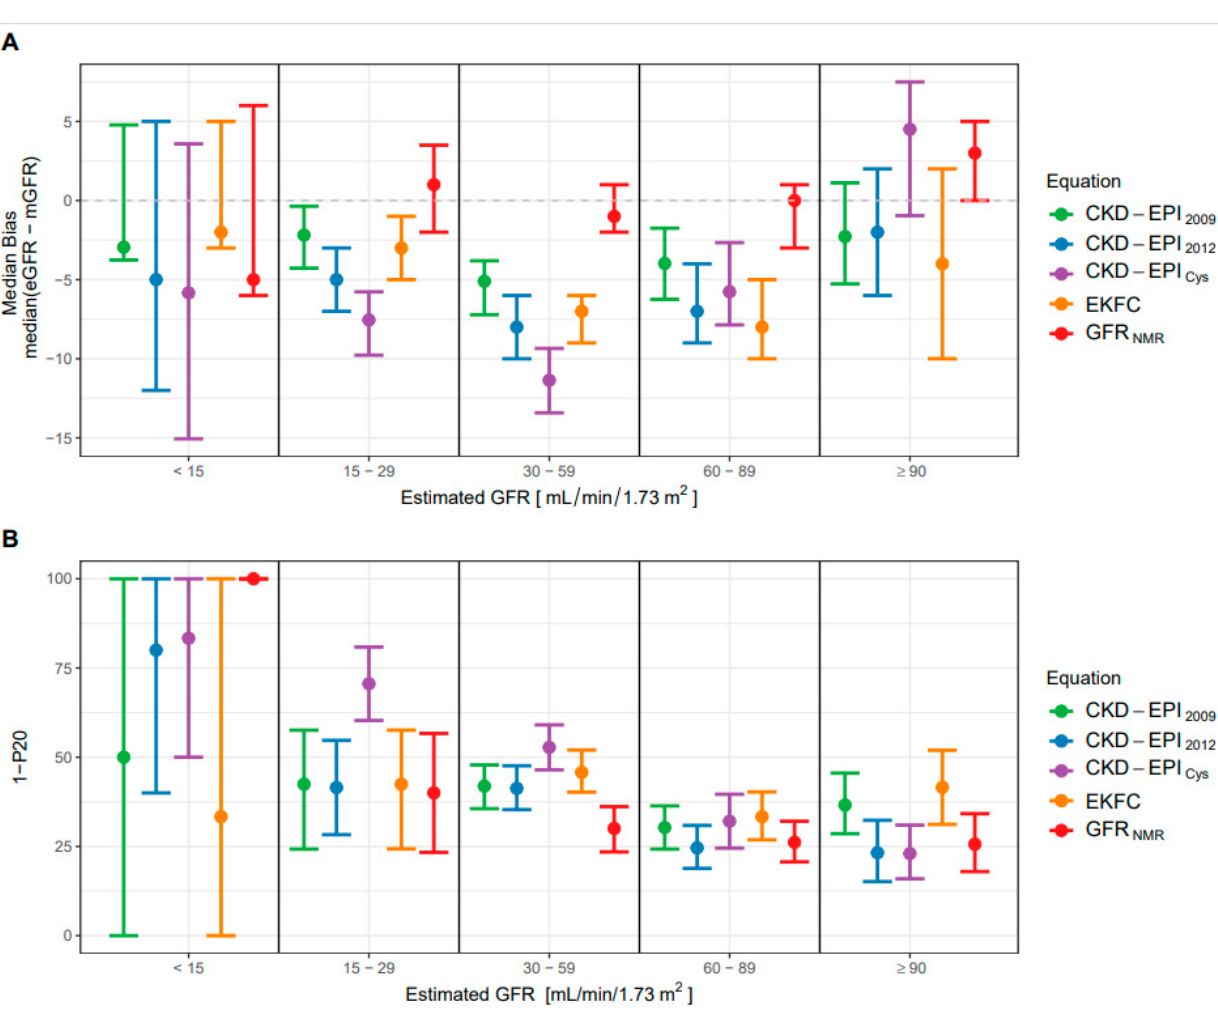
Figure 1. Performance of the eGFR ‐ estimating equations. ( A ) Median bias ± 95% confidence intervals (CI) according to different ranges of eGFR (mL/min/1.73 m 2 of body ‐ surface area) for the GFR NMR , CKD ‐ EPI 2009 , CKD ‐ EPI 2012 , CKD ‐ EPI Cys and EKFC equations. ( B ) Accuracy (1 ‐ P20 ± 95% CI) according to different ranges of estimated GFR (mL/min/1.73 m 2 of body ‐ surface area) for the GFR NMR , CKD ‐ EPI 2009 , CKD ‐ EPI 2012 , CKD ‐ EPI Cys and EKFC equations. 1 ‐ P20 is the percentage of eGFR values lying outside the tolerance range of 20% of measured GFR. In ( A , B ), the range of n values per eGFR subgroup are as follows: 3 to 6 for eGFR < 15 mL/min/1.73 m 2 , 30 to 68 for 15–29 mL/min/1.73 m 2 , 213 to 271 for 30–59 mL/min/1.73